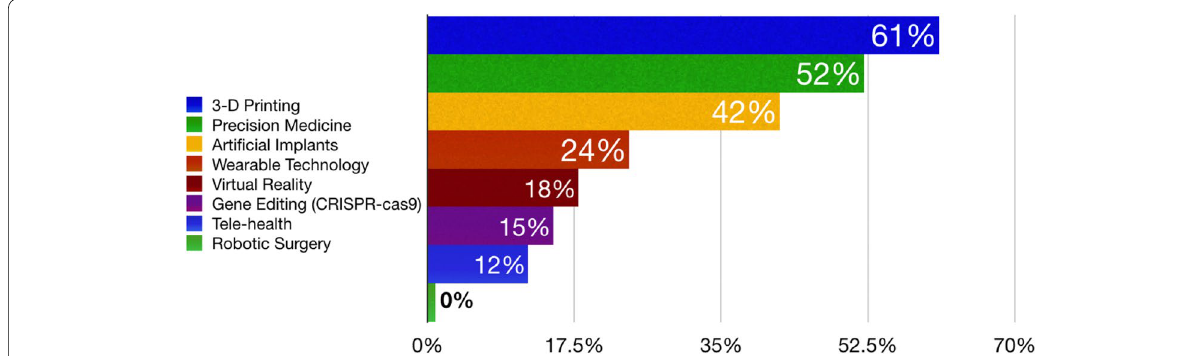
Fig. 3 Top ranked emerging medical technologies to have the greatest impact for furthering meniscus